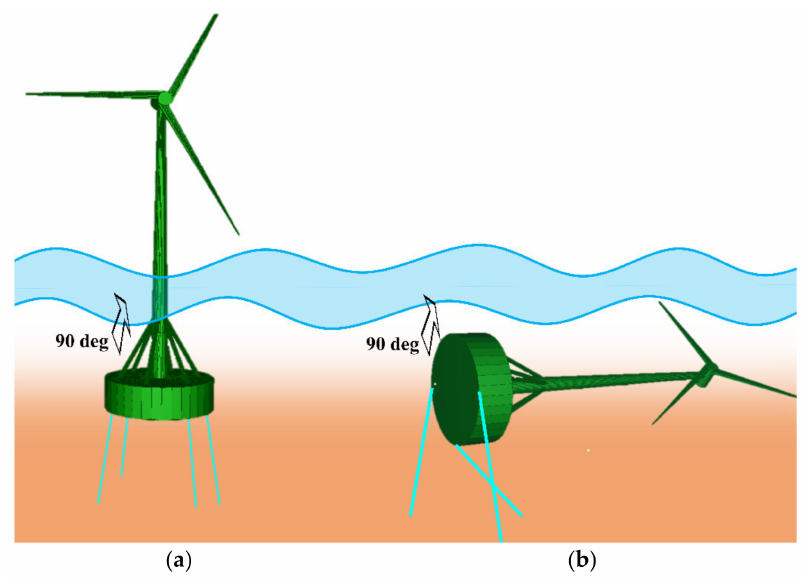
Figure 15. Failure analysis of tension leg under the 4 tension legs condition: ( a ) normal and ( b ) p1 failure (collapse).